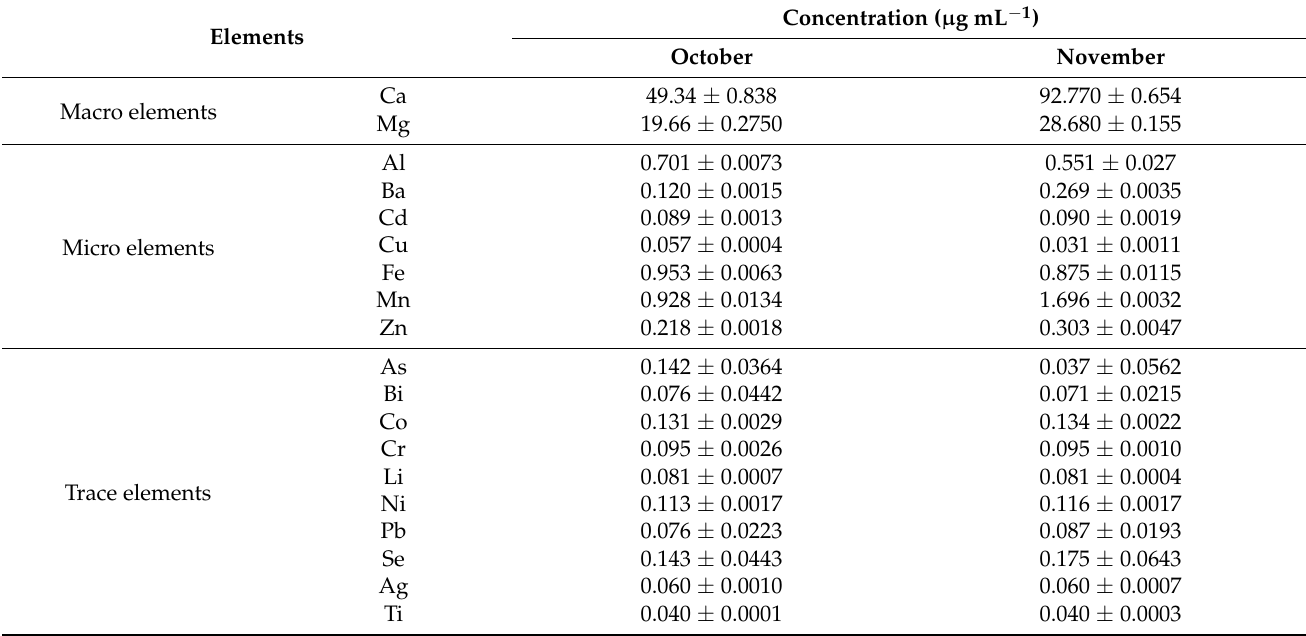
Table 4. Mineral content in the A. japonica root